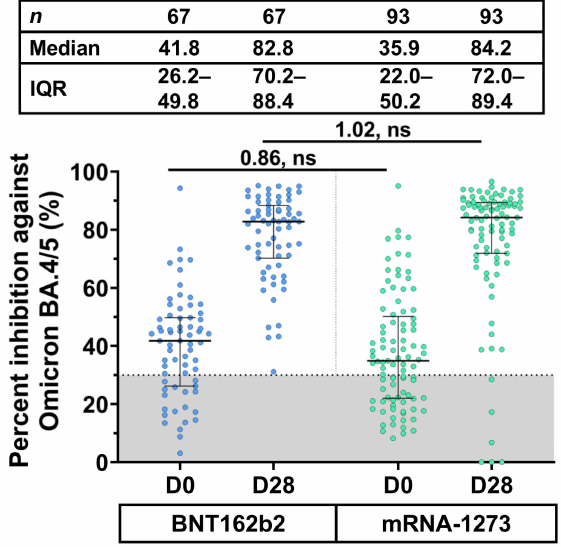
Figure 4. Neutralizing activity of participants against the SARS-CoV-2 Omicron BA.4/5 at 28 days after the fourth dose. Sera were obtained from a subset of individuals at baseline (D0) and at 28 days (D28) after receiving a booster dose of BNT162b2 and mRNA-1273. The gray area indicates the neutralizing activity of the SARS-CoV-2 Omicron BA.4/5 (<30%). Lines represent the medians (%) with interquartile range (IQR) values. A pairwise comparison displays the median ratio and the lack of statistical significance